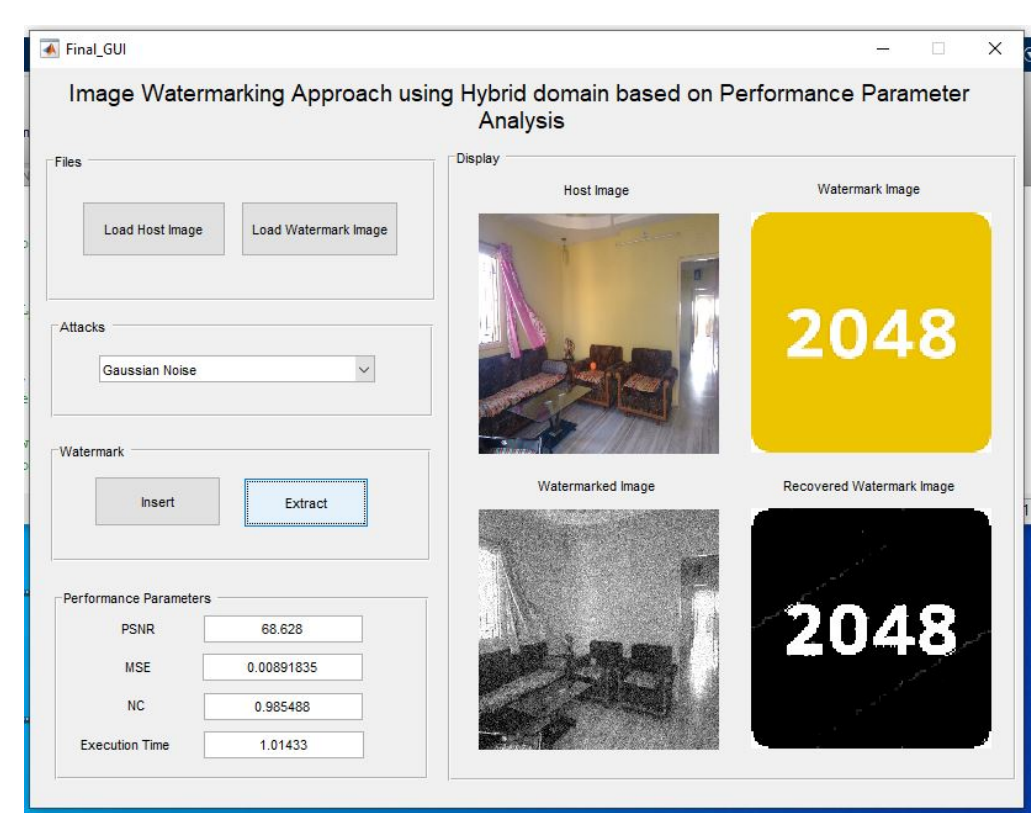
Figure 16. Adding Gaussian noise, and extraction after adding noise. In the Figure 17, the watermarked image is sharpened and then the watermark is extracted using the extraction method.